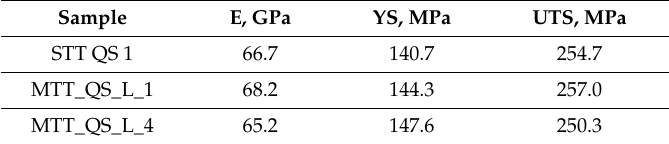
Table A3. Tensile tests results for QS material.